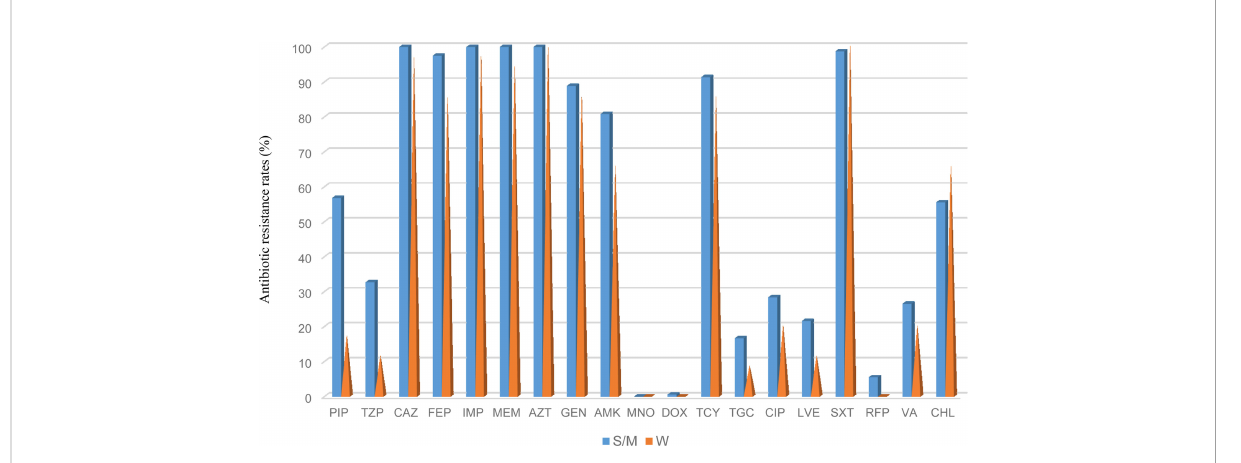
FIGURE 3 The frequency of antibacterial resistance in strong/moderate bio fi lm formation and weak bio fi lm producer E. anophelis isolates. S/W, strong or moderate bio fi lm formation; W, weak bio fi lm formation. PIP, piperacillin; TZP, piperacillin-tazobactam; CAZ, ceftazidime; FEP, cefepime; IPM,